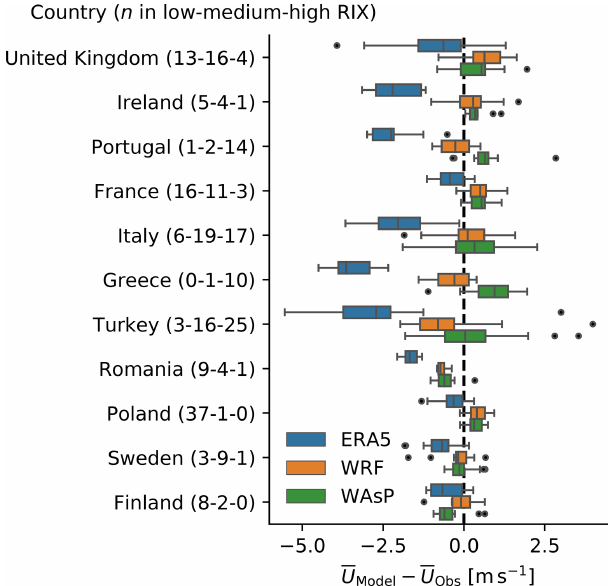
Figure 10. Boxplots of the distribution of mean wind speed biases ( U Model − U Obs ) by ERA5, WRF, and WAsP for the 11 countries containing most masts. The number of masts in each ruggedness in- dex (RIX) category is shown in the parenthesis. The boxes indicate the 2nd and 3rd quartiles. Whiskers extend to 1 . 5 × the interquartile range (extent of 2nd and 3rd quartile) or to the outermost data point. Points indicate outliers outside the 1 . 5 × interquartile